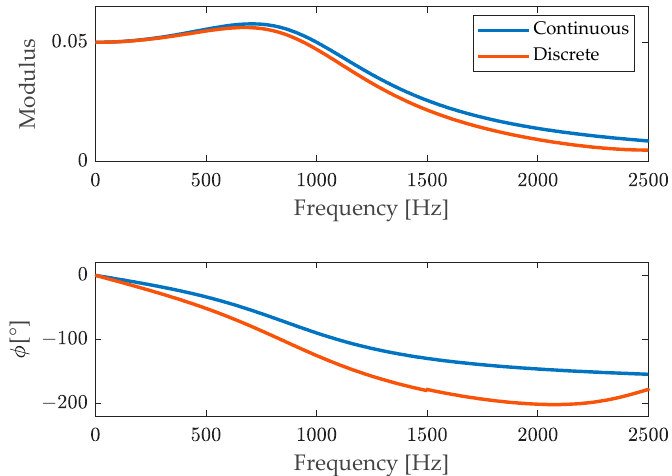
Figure 3. Comparison of the frequency response of the original system and of the corresponding one coming from the discrete model.